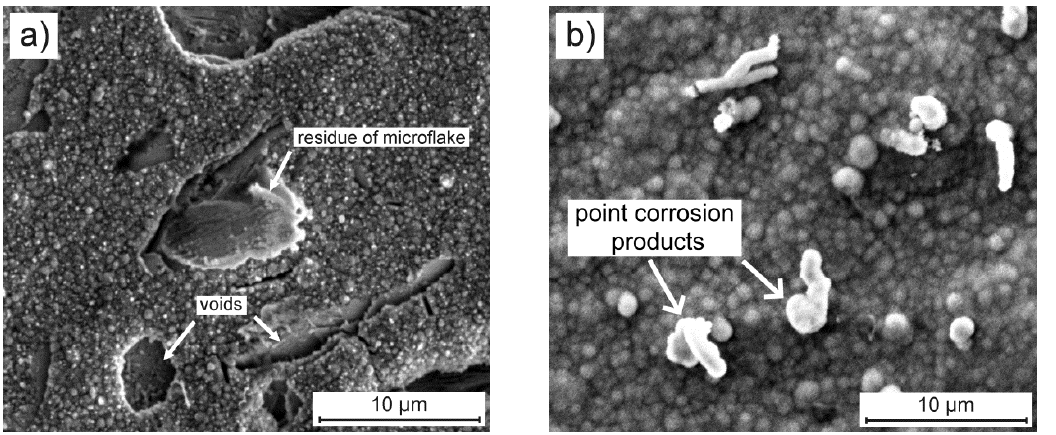
Figure 11. Surface morphology of ( a ) composite and ( b ) blank Ni coatings (deposited on the copper substrate at a current density of 6 mA cm − 2 at 70 °C for 1 h) after one-week exposure to 0.05 M NaCl solution.